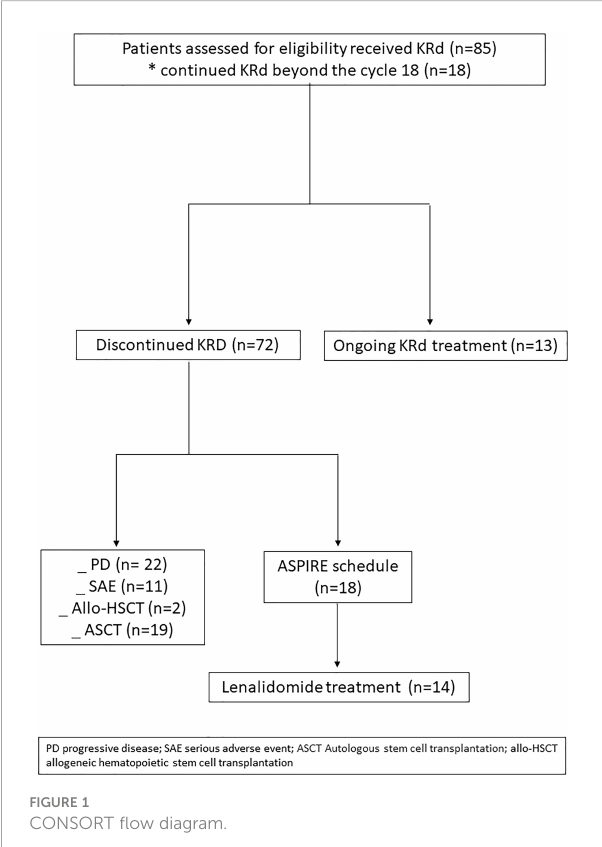
FIGURE 1 CONSORT fl ow